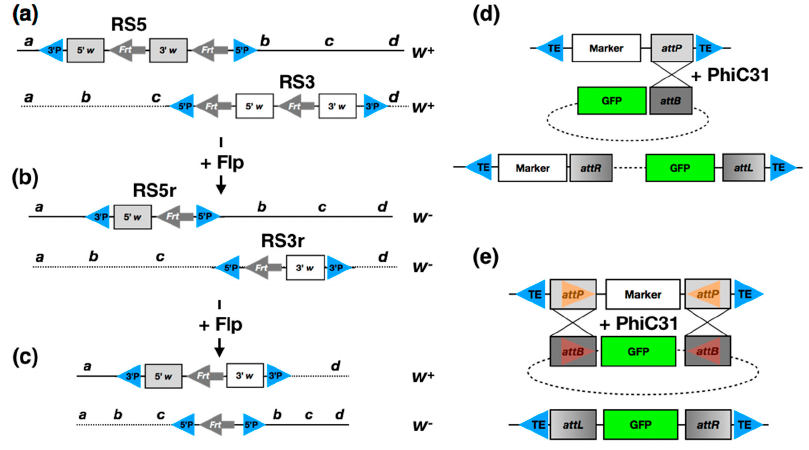
Figure 1. Genome engineering. ( a – c ) The Golic method for generating precise chromosomal deletions. ( a ) Two P elements, designated RS3 and RS5, are inserted at different locations (designated by a–d) on two homologous chromosomes and kept in separate fly lines. The elements contain a functional mini- white gene composed of multiple exons that for simplicity are drawn as grey or white boxes, representing 5 ′ and 3 ′ portions of the gene. There are two Frt sites (grey arrows) in each element, one of which is located within a mini- white exon . The elements differ in the position of the second Frt site and the orientation of the construct with respect to the P element ends (blue triangles). ( b ) Internal Flp-driven recombination between the Frt sites produces remnant forms of the white genes such that RS5r contains the 5 ′ end and RS3r the 3 ′ end with the intronic FRT site remaining. Each of these remnant elements are generated in separate fly lines that are phenotypically white eyed. ( c ) RS5r and RS3r elements are brought together in trans in a fly along with a source of Flp recombinase. FLP-mediated recombination between the elements produces a reconstituted functional white gene and the intervening genomic DNA is deleted. The reciprocal event creates a tandem duplication of the deleted segment, separated by an FRT site, but no white gene. ( d ) The PhiC31 system. A transposon (blue triangles mark the transposon ends) carrying a marker gene for genetic tracking and an attP site is inserted into the genome. Providing an attB containing plasmid with a gene or sequence of interest, in this case GFP, and a source of PhC31 integrase results in high efficiency integration of the plasmid into the genomic location. ( e ) Recombinase-mediated cassette exchange (RMCE). A transposon (blue triangles mark the transposon ends) carrying a marker gene flanked by attP site is inserted into the genome. Providing a plasmid with a gene or sequence of interest, in this case GFP, flanked by attB sites and a source of PhC31 recombinase results in high efficiency replacement of the genomic marker with the sequence of interest. With RMCE the inverted orientation of the attP and attB sites is critical for producing the desired exchange.